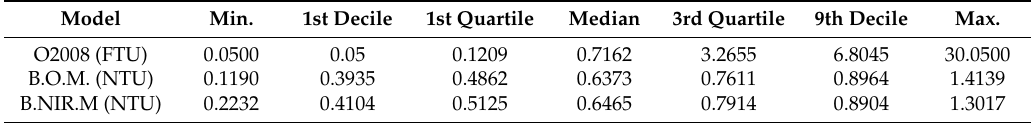
Table 4. Main quantile values of turbidity estimations by the O2008 model, the B.O.M. and the B.NIR.M. (see Sections 3.1 and 3.3) in the Voh-Kon é -Pouembout lagoon area on 24 June